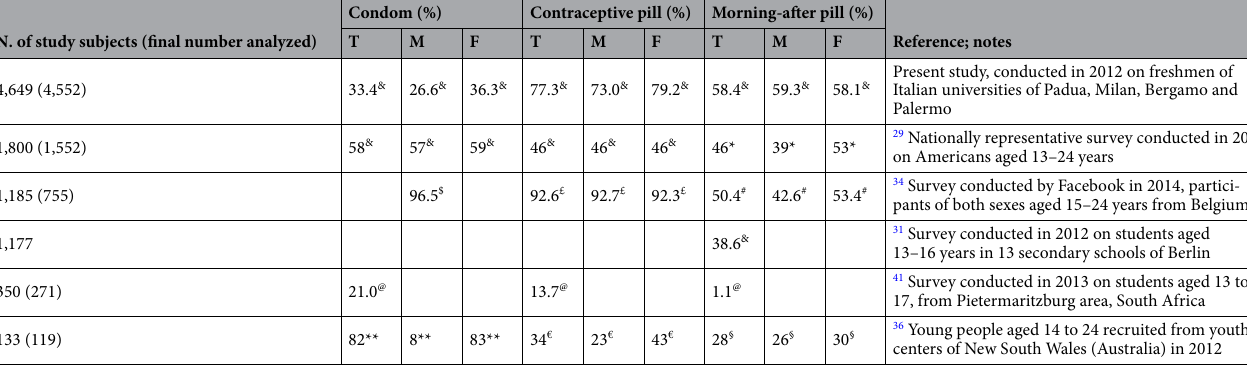
Table 6. Knowledge of three main contraceptive methods and/or their efficacy and/or their mechanism of action to prevent unintended pregnancies, among male and female adolescents and young adults; present results compared with published findings. T = Total study subjects; M = Males; F = Females. & Knowledge of contraceptive efficacy; *Knowledge of something a woman can do after unprotected sex, having heard about morning after pill; $ Correct answer to the question: The expiration date of a condom is not important (false); £ Correct answer to the question: The contraceptive pill prevents unintended pregnancies (true); #